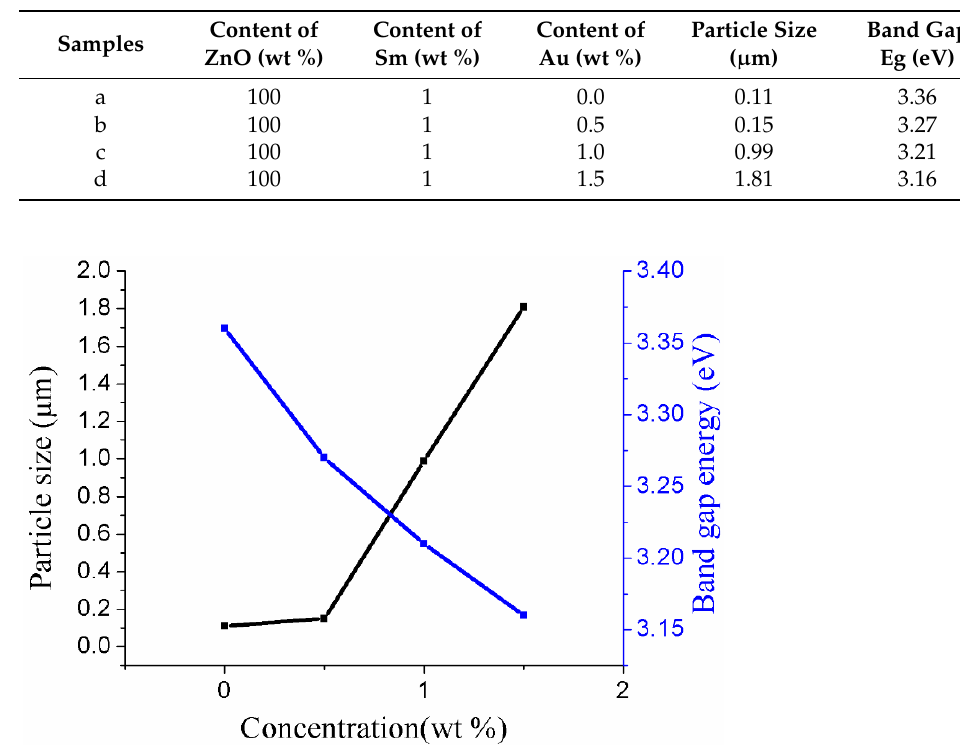
Table 2. Grain size and bandgap energy of Au (0.0, 0.5, 1.0 and 1.5 wt %)-doped ZnO–Sm nanoparticle films.